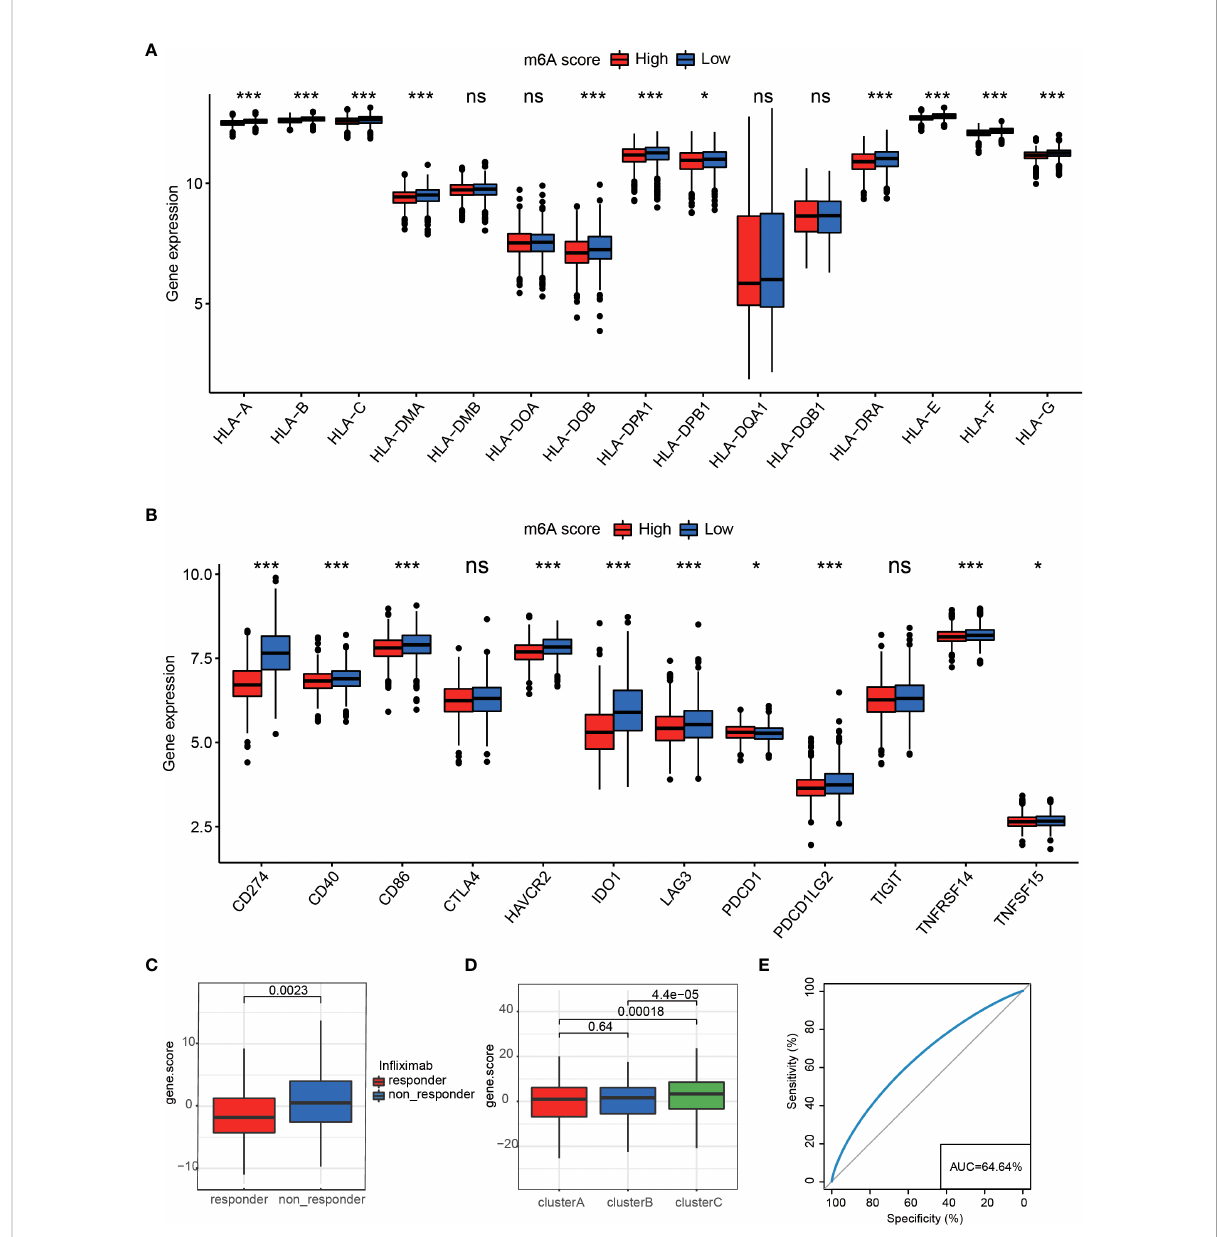
FIGURE 6 (A) The expression differences of HLA between two different groups *P < 0.05, ***P < 0.001, ns P>=0.05. (B) Differences in 12 critical immune checkpoints between high m6Ascore and low m6Ascore groups *P < 0.05, ***P < 0.001, ns P>=0.05. (C) M6Ascore in the in fl iximab treatment responder and non-responder patients. (D) M6Ascore in three m6A clusters (Wilcoxon test). (E) ROC curve of the m6Ascore in RA responder and non-responder samples, suggesting that the m6Ascore feature could predict patients ’ response